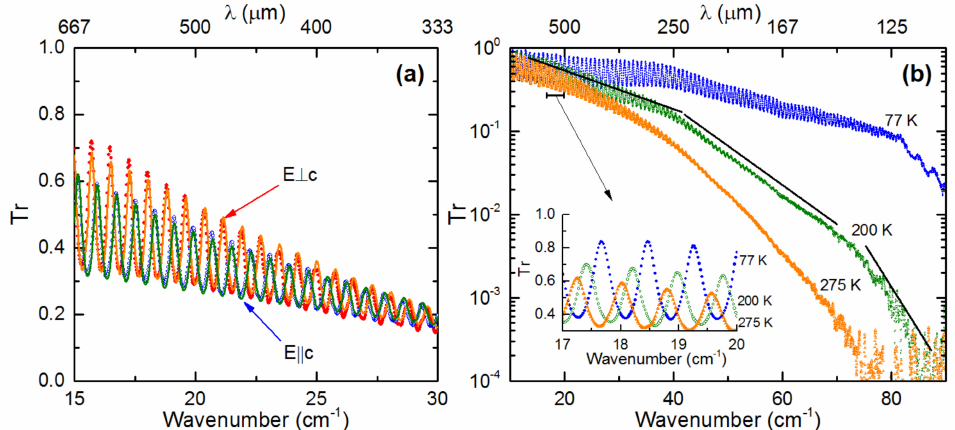
Figure 4. Scaled part of transmission spectra of the LiGdF 4 single crystal in the THz range for E ⊥ c and E (cid:107) c polarization. Points represent the experimental data, and solid lines correspond to the spectra calculated by Fresnel–Lorentz model ( a ). Temperature dependence of the transmission spectra of the single crystal LiGdF 4 in E ⊥ c polarization ( b